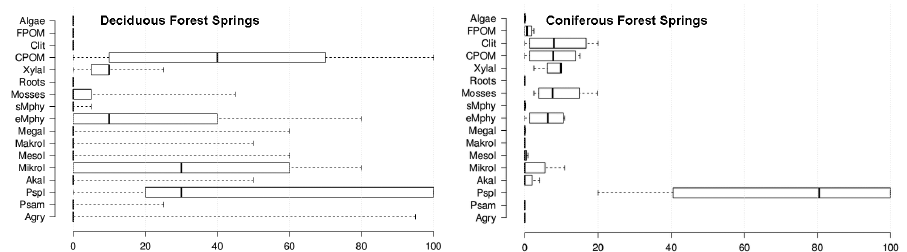
Figure 4. Cover ratio of microhabitats in deciduous (left) and coniferous (right) forest headwater